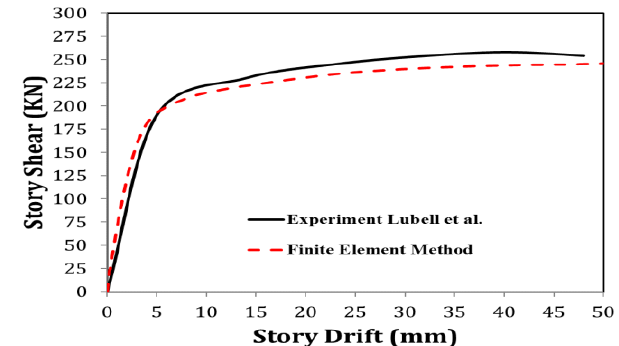
Fig. 4 . Comparison of finite element method with experimental results.